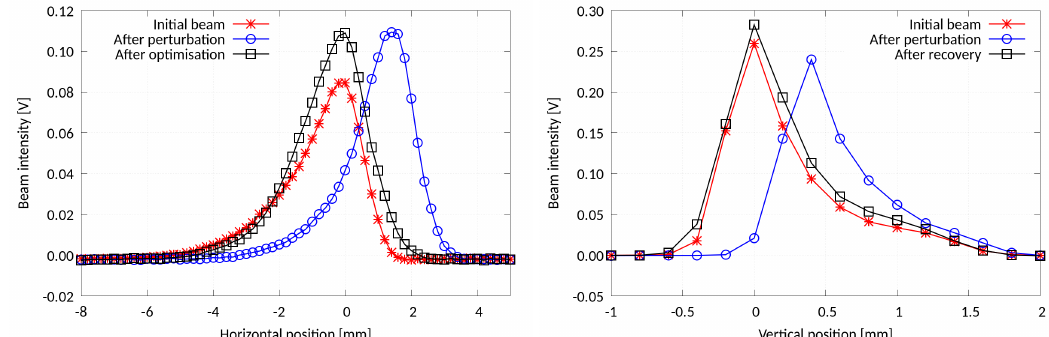
Figure 8. Capability of the AFS to restore the initial beam conditions after a perturbation. Horizontal ( left ) and vertical ( right ) beam profiles measured by a two-dimensional UniBEaM located at the position of the target. The output of the photo-diode of the commercial UniBEaM is reported in